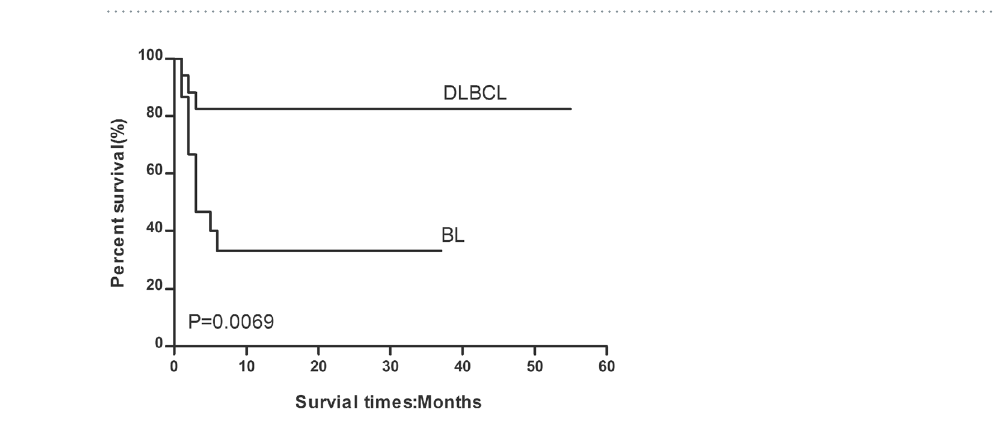
Figure 2. Overall survival curve for BL patients receiving CODOX-M/IVAC ± R and DLBCL patients receiving CHOP ± R chemotherapy.